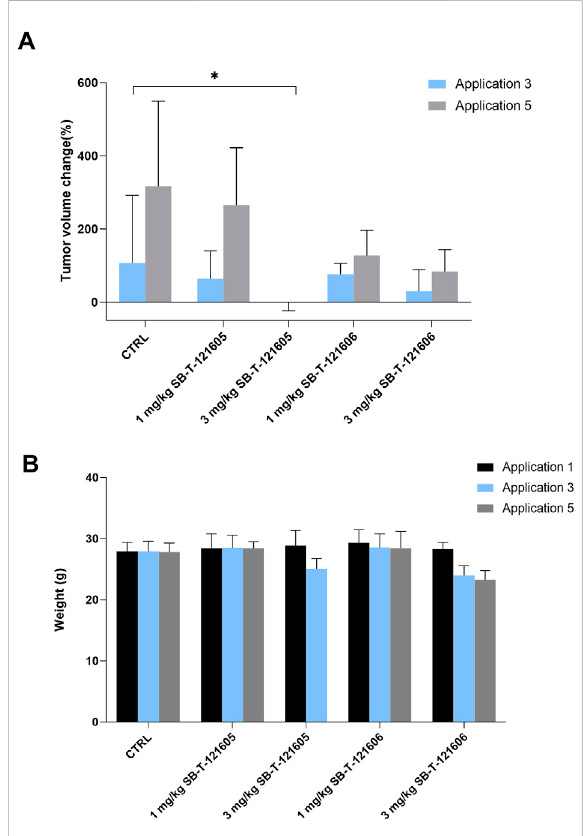
FIGURE 8 In vivo ef fi cacy of SB-T-121605. (A) Changes of tumor volume (%) during experiment in comparison to situation before the fi rst application. Ef fi cacy was compared between control group, experimental group treated with 10 mg/kg PTX alone, and groups treated with combinations of a/9 mg/kg PTX with 1 mg/kgSB-T-121605,b/7 mg/kgPTXwith3 mg/kgSB-T-121605, and c/5 mg/kg PTX with 5 mg/kg SB-T-121605. (B) Changes of mouse weight (g) during the application in all examined experimental groups. * p -values by two-tailed Student´s t-test (* p ≤ 0.05).